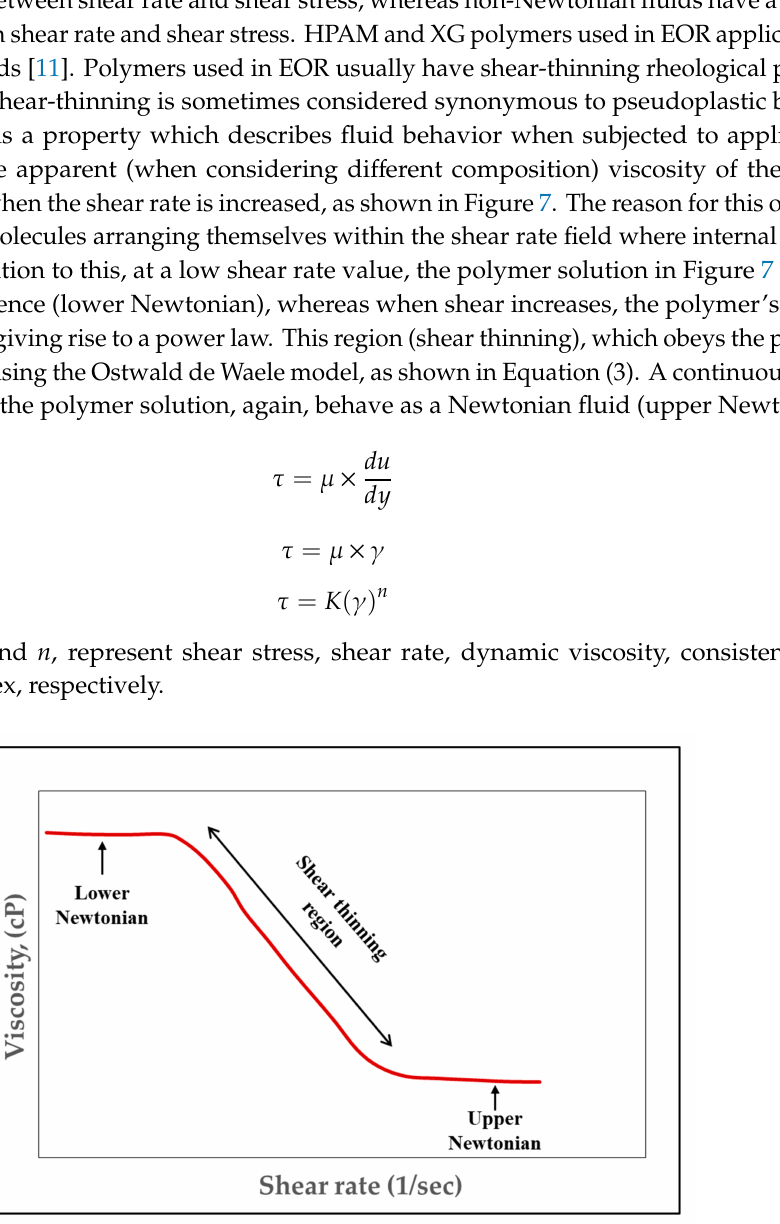
Figure 7. Rheology of a shear-thinning fluid (Log-Log plot). Reprinted and modified from